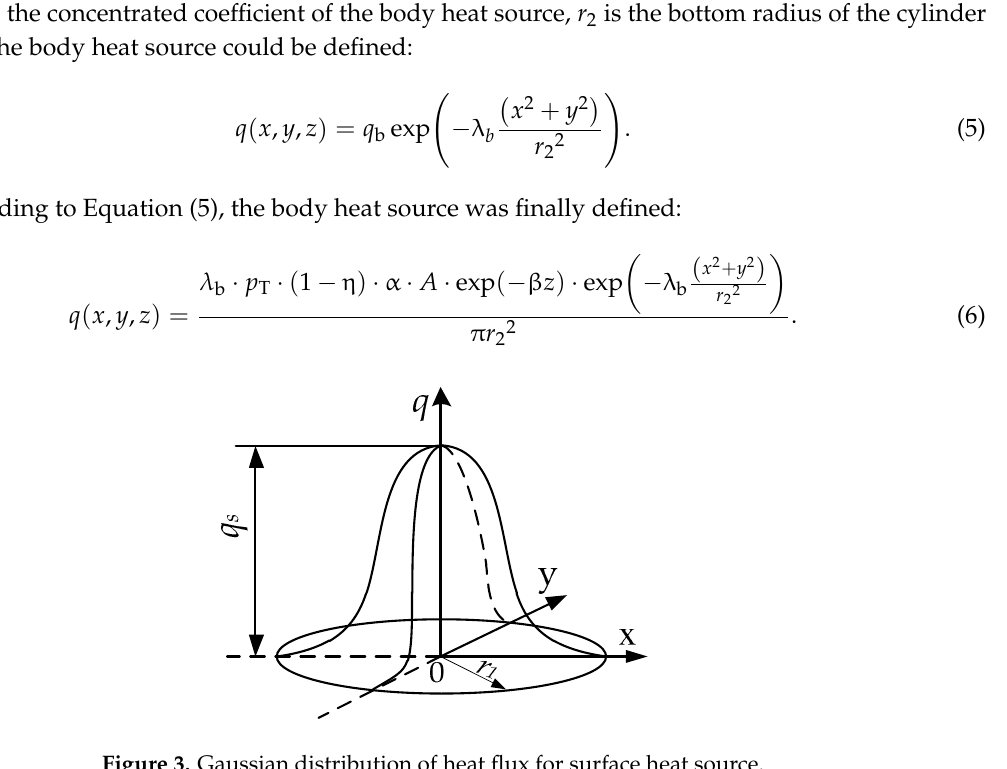
Figure 3. Gaussian distribution of heat flux for surface heat source.